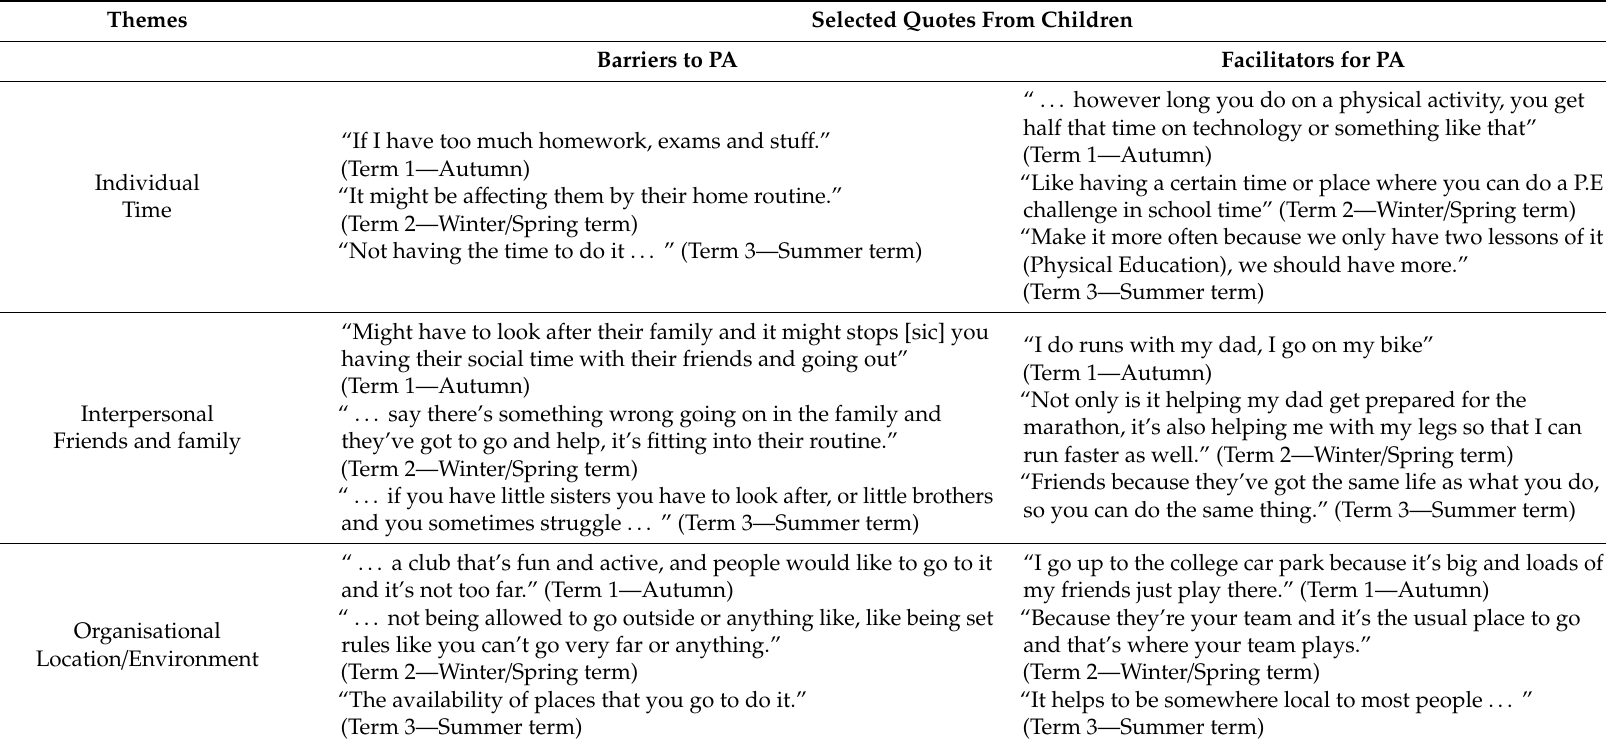
Table 3. A summary of themes and examples of raw data extracts for barriers to and facilitators for